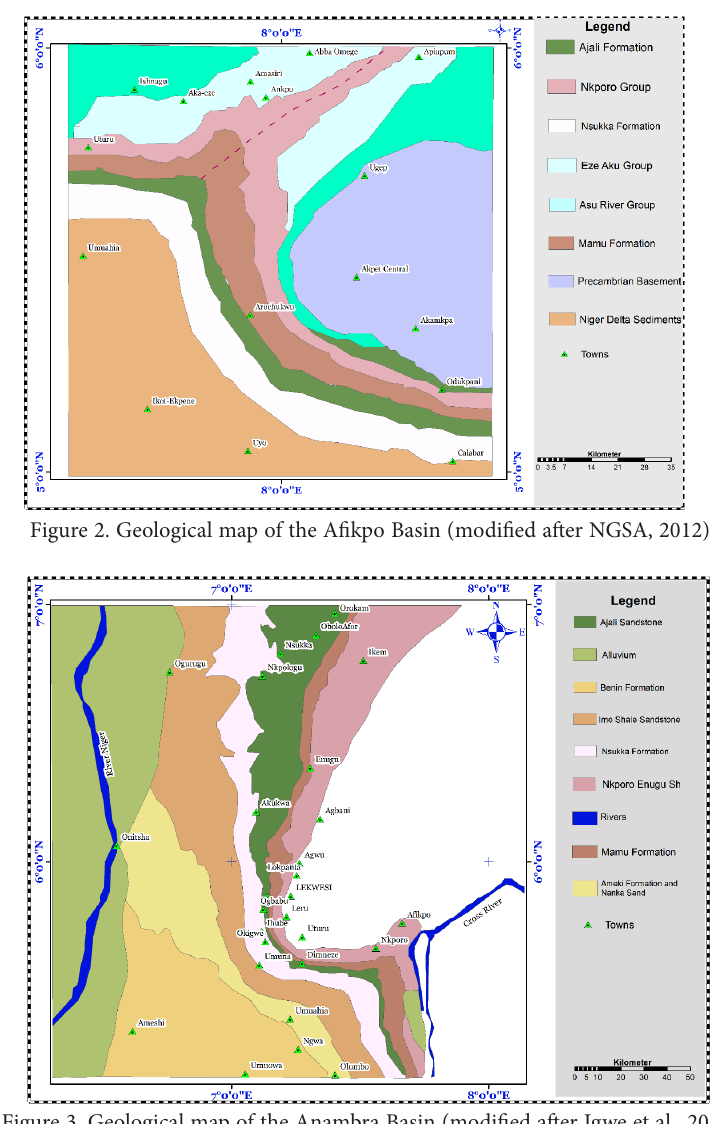
Figure 3. Geological map of the Anambra Basin (modified after Igwe et al.,